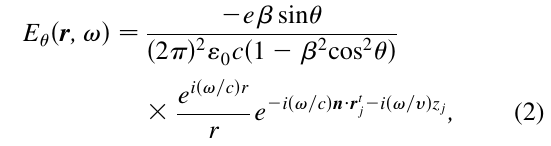
FIG. 1. Snapshot of electron traveling with speed v (cid:5) v e taken at t (cid:5) 0 to illustrate the definition of the coordinates. The position of the electron at t (cid:5) 0 is r 0 is occupied by a metal, the half-space z > 0 is vacuum. The observation vector r makes an angle (cid:1) with the z